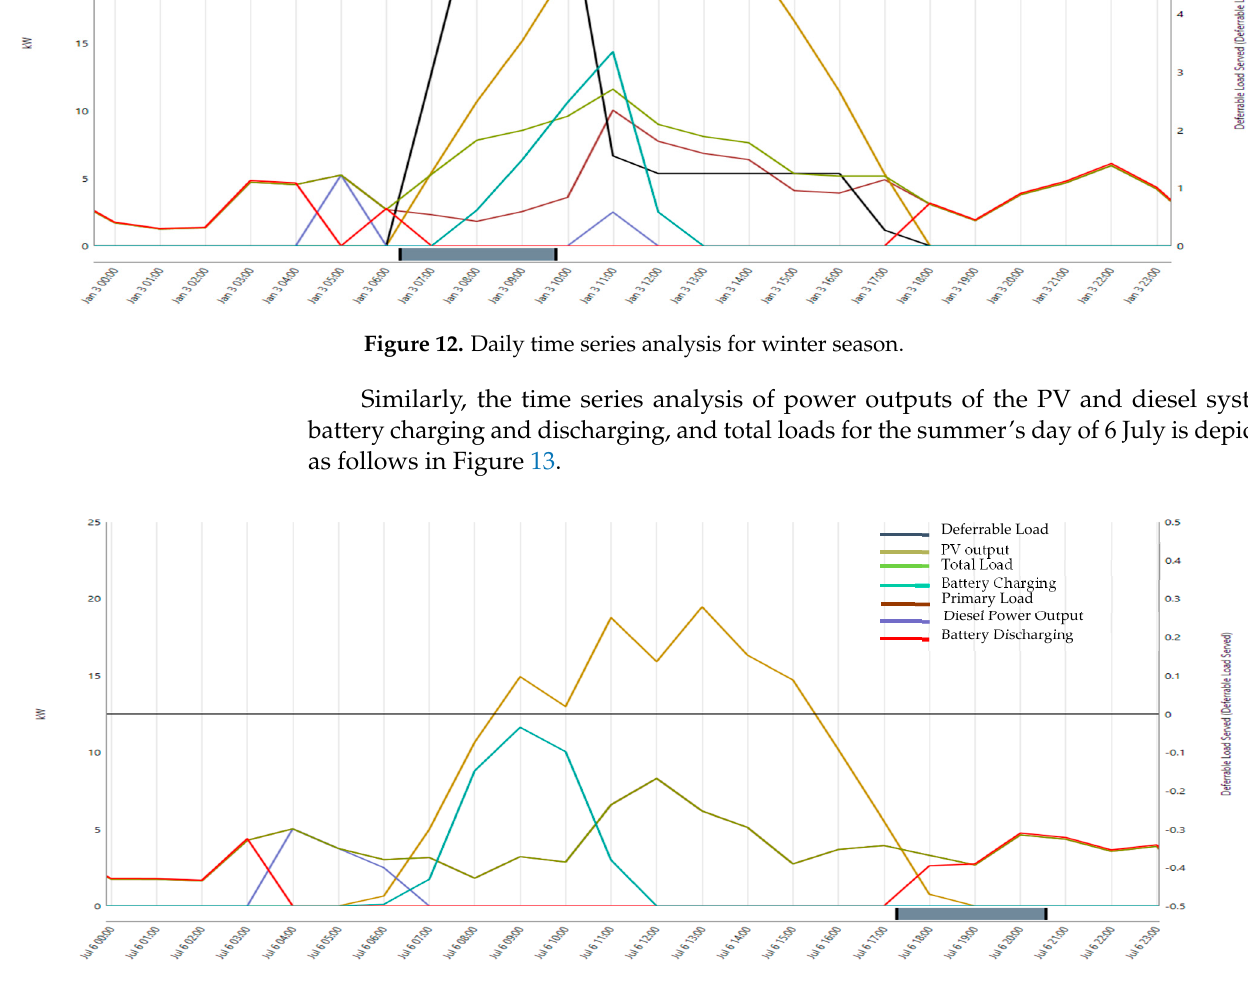
Figure 13. Daily time series analysis for summer season.